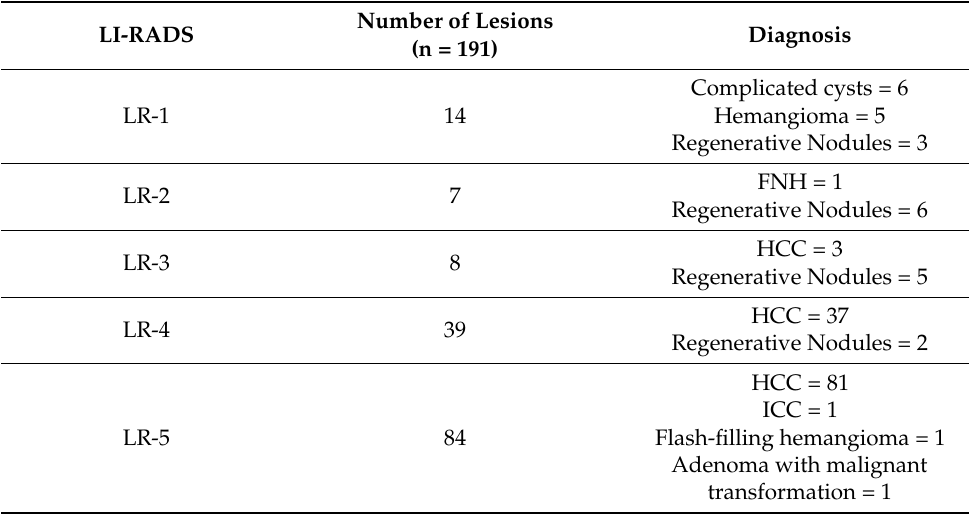
Table 4. The rates of different cellular types of nodules according to LI-RADS